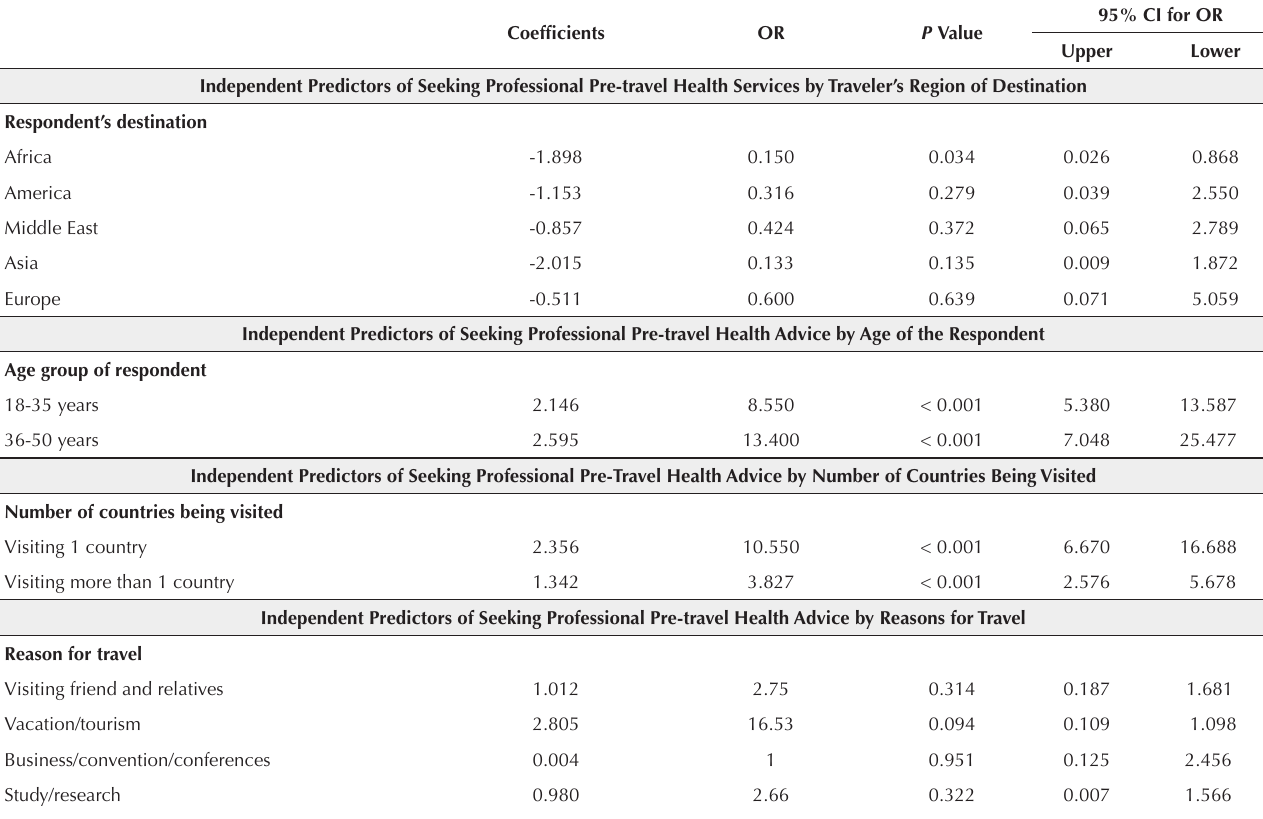
Table 3. Independent Predictors of Seeking Professional Pre-travel Health Services